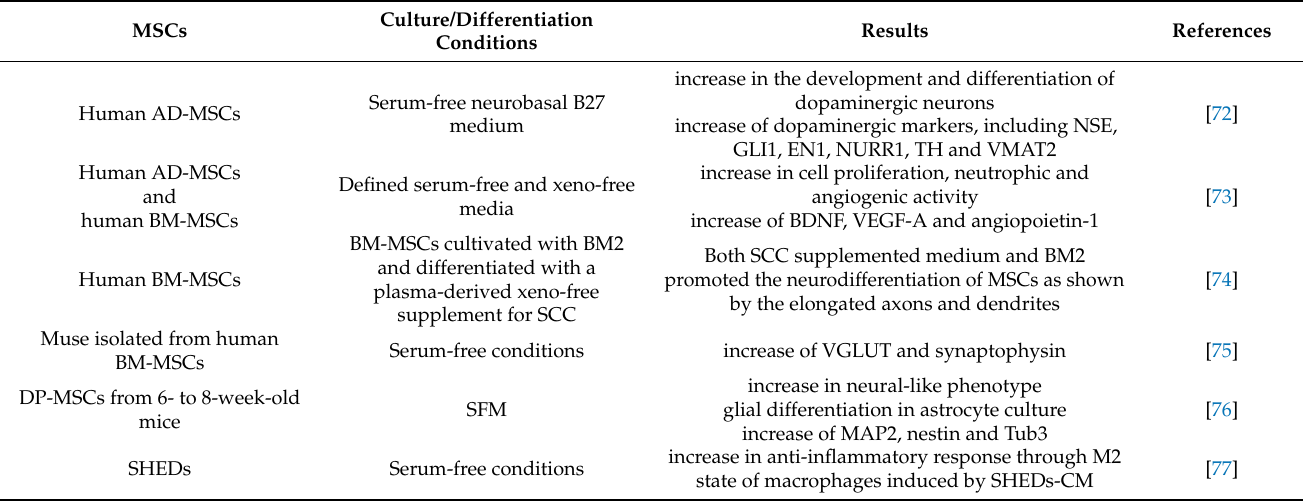
Table 4. Summary of the in vitro studies that showed the effects of chemically defined medium in MSC